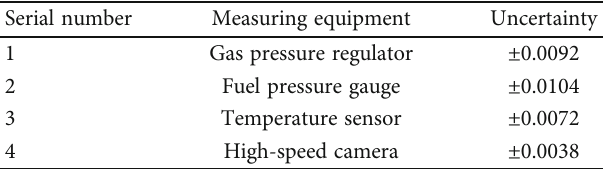
Table 5: Uncertainty analysis of measuring